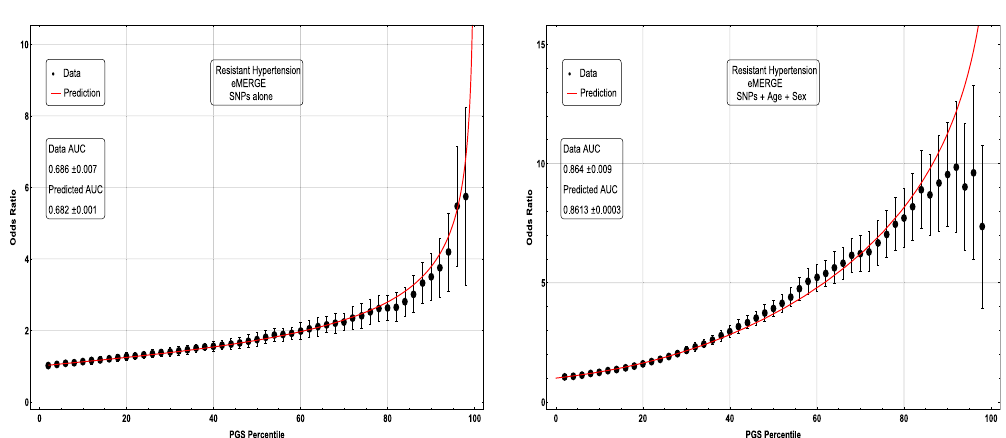
Figure 11. Odds ratio between upper percentile in PGS and total population prevalence in eMERGE for Resistant Hypertension with and without using age and sex as